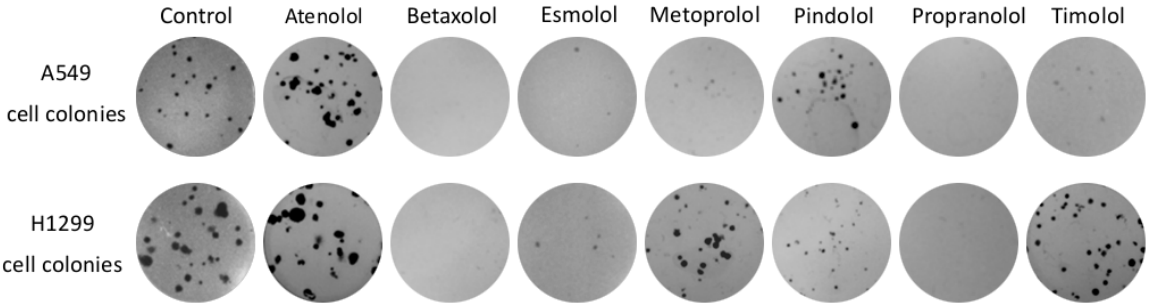
Figure 2. A549 and H1299 cell colonies after incubation with 90% of EC 50 concentrations of beta adrenoblockers. Each figure represents the whole area of the well bottom from the 12-well plate.